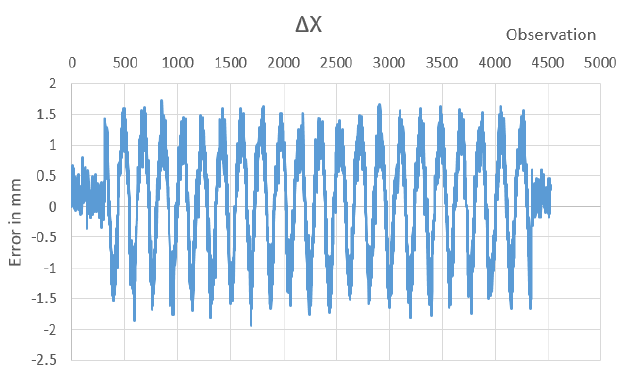
Figure 15. Difference between photogrammetry from the second monitoring station using Faster R-CNN and a Harris corner detector.